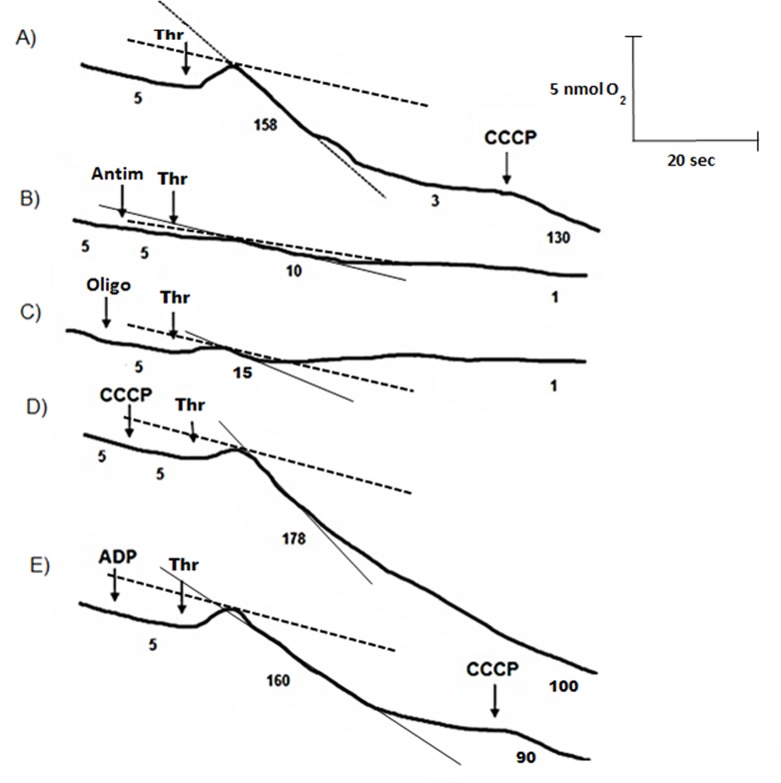
Effect of thrombin (Thr), OxPhos inhibitors and uncouplers in platelet oxygen consumption.Oxygen consumption in platelet-rich plasma was determined as described under “Material and Methods”. Arrows show Thr (0.5 U/ml), ADP (10 μM); CCCP (2.5 μM), oligomycin (Oligo, 5 μM) or antimycin (Antim, 5 μM) additions. Numbers under the traces indicate the rate of oxygen consumption in nanogram atom oxygen/min/109 platelets. The lines over each trace indicate the change in oxygen consumption before (dashed lines) and after (solid lines) the addition of thrombin. Experimental traces are representative of at least 4 independent measurements.